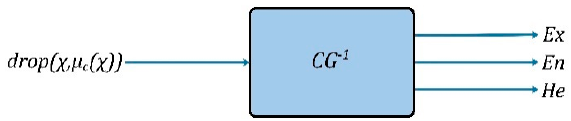
Figure 5. Reverse Cloud Generator.